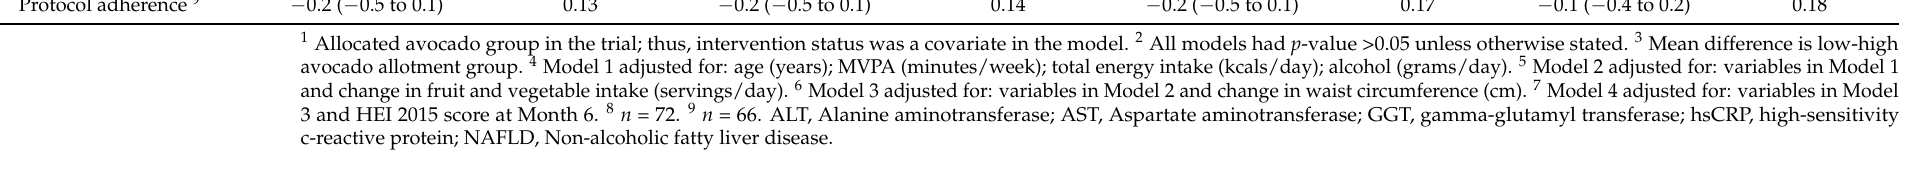
Table 7. Between-group differences of multivariable linear regression models assessing 6-month changes in hepatic function markers related to avocado 1 allotment, per intention-to-treat and per protocol adherence analyses 2 , stratified by prediabetes status 3